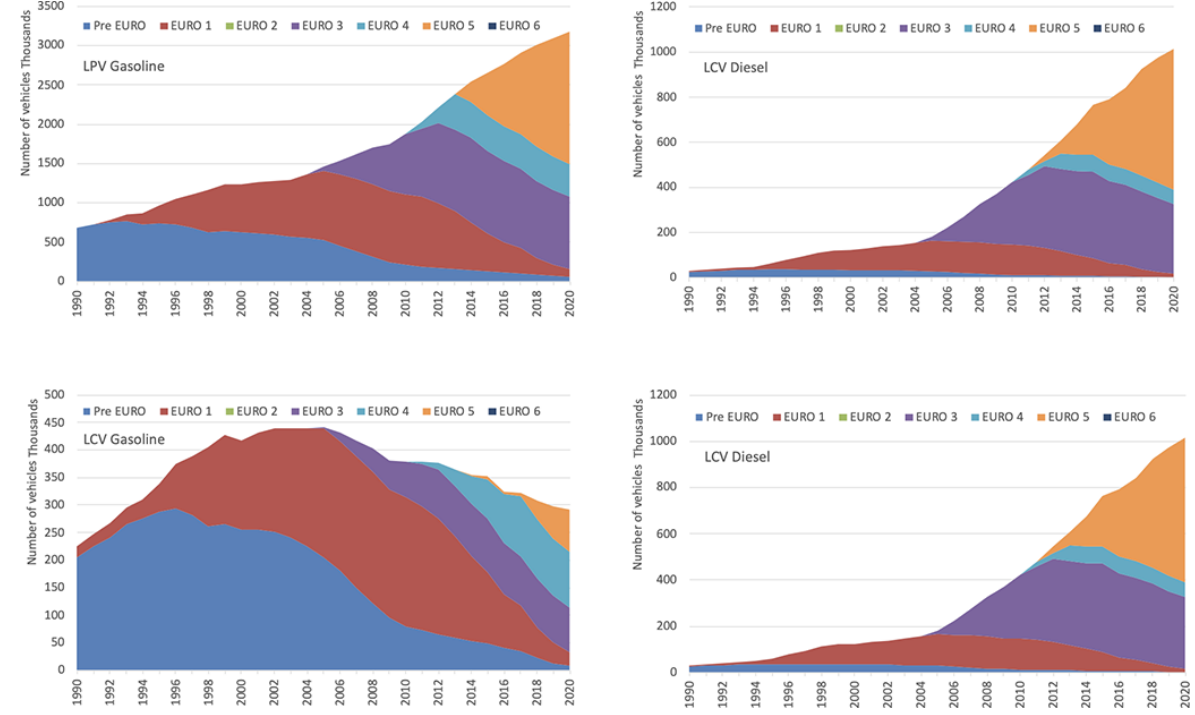
Figure 3. Emission standards and vehicle fleet in Chile, 1990–2020, for light passenger vehicles (LPV) and light commercial vehicles (LCV), using gasoline and diesel respectively. Table 5. Emission factors used for different compounds and vehicle categories in Chile, the numbers 0–6 indicate the corresponding Euro standards, and the letters G and D correspond to gasoline and diesel